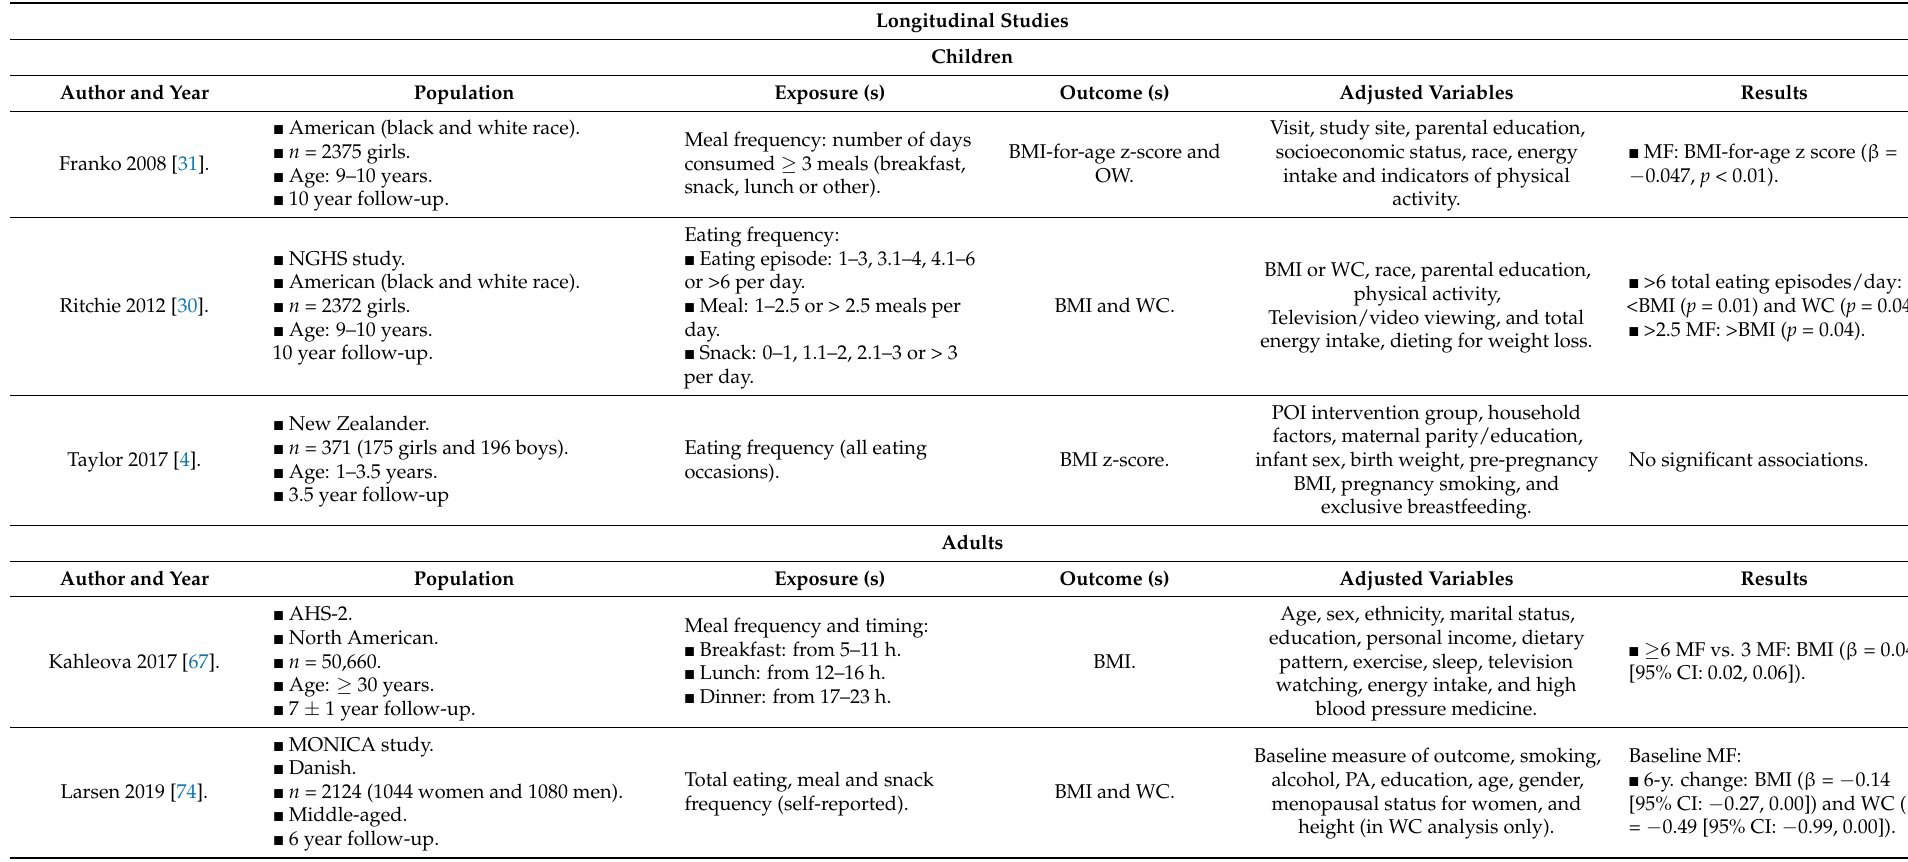
Table 4. Characteristics and main findings of longitudinal studies that explored eating frequency. Longitudinal Studies